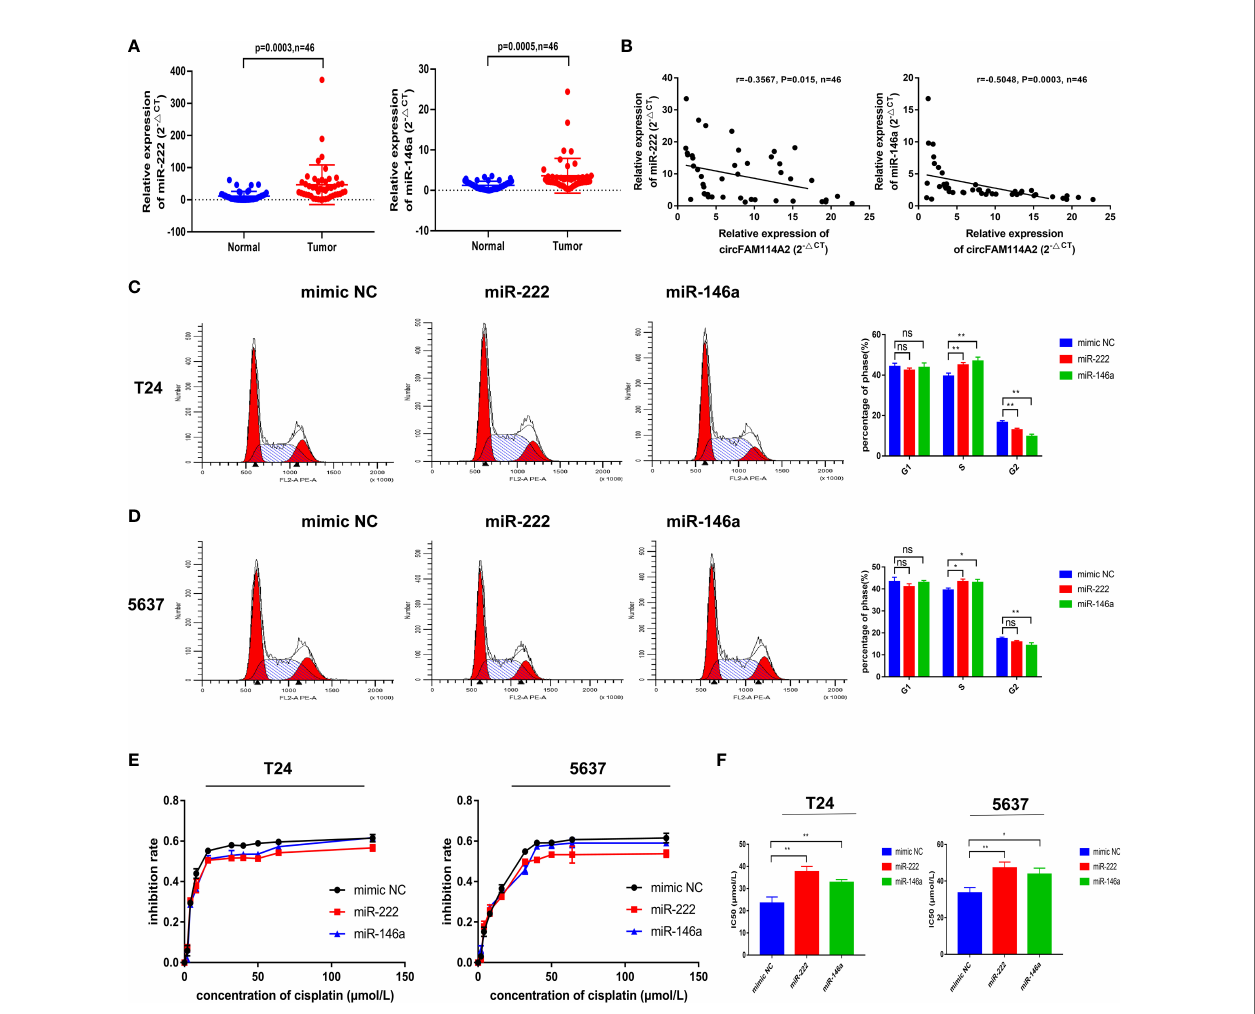
FIGURE 4 | MIR-222-3p/146a-5p attenuated cell cycle arrest and decreased cisplatin chemotherapy sensitivity. (A) Quantitative real-time PCR (qRT-PCR) revealed that miR-222-3p and miR-146a-5p were upregulated in urothelial carcinoma tissues ( n = 46) compared with normal adjacent bladder tissues. (B) A negative correlation between the expressions of circFAM114A2 and miR-222-3p/miR-146a-5p was shown using Pearson ’ s correlation analysis. (C, D) Illustrations of the fl ow cytometry assays in miR-222-3p/miR-146a-5p mimic transfected T24 and 5637 cells. More cells were distributed in the S phase of the miR-222-3p/miR-146a-5p mimic group compared with the control group in T24 and 5637 cell lines (Student ’ s t -test: * p < 0.05, ** p < 0.01). ns, no signi fi cant. (E) Cell viability curve of the cisplatin treatment assays in the miR-222-3p/miR-146a-5p mimic group and relative control group. (F) IC 50 values showed that the overexpression of miR-222-3p and miR-146a-5p could decrease the sensitivity of T24 and 5637 cells to cisplatin (Student ’ s t -test: * p < 0.05, ** p < 0.01). Data are the mean ± SD, n =